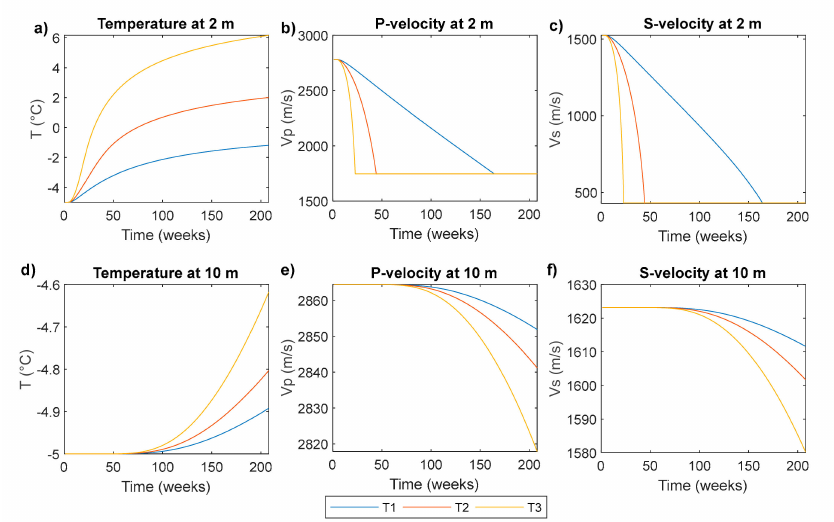
Figure 2. Variation in temperature and seismic velocities with time throughout four years at two stationary points for the models T1 (top boundary temperature = + 1 ◦ C), T2 (top boundary temperature = + 5 ◦ C ), and T3 (top boundary temperature = + 10 ◦ C ): ( a ) temperature at 2 m depth, ( b ) P-wave velocity at 2 m depth, ( c ) S-wave velocity at 2 m depth, ( d ) temperature at 10 m depth, ( e ) P-wave velocity at 10 m depth, ( f ) S-wave velocity at 10 m depth. Note the di ff erent axis scales for the two depths. The velocity decrease for all models is caused by the decreasing ice saturation due to temperature